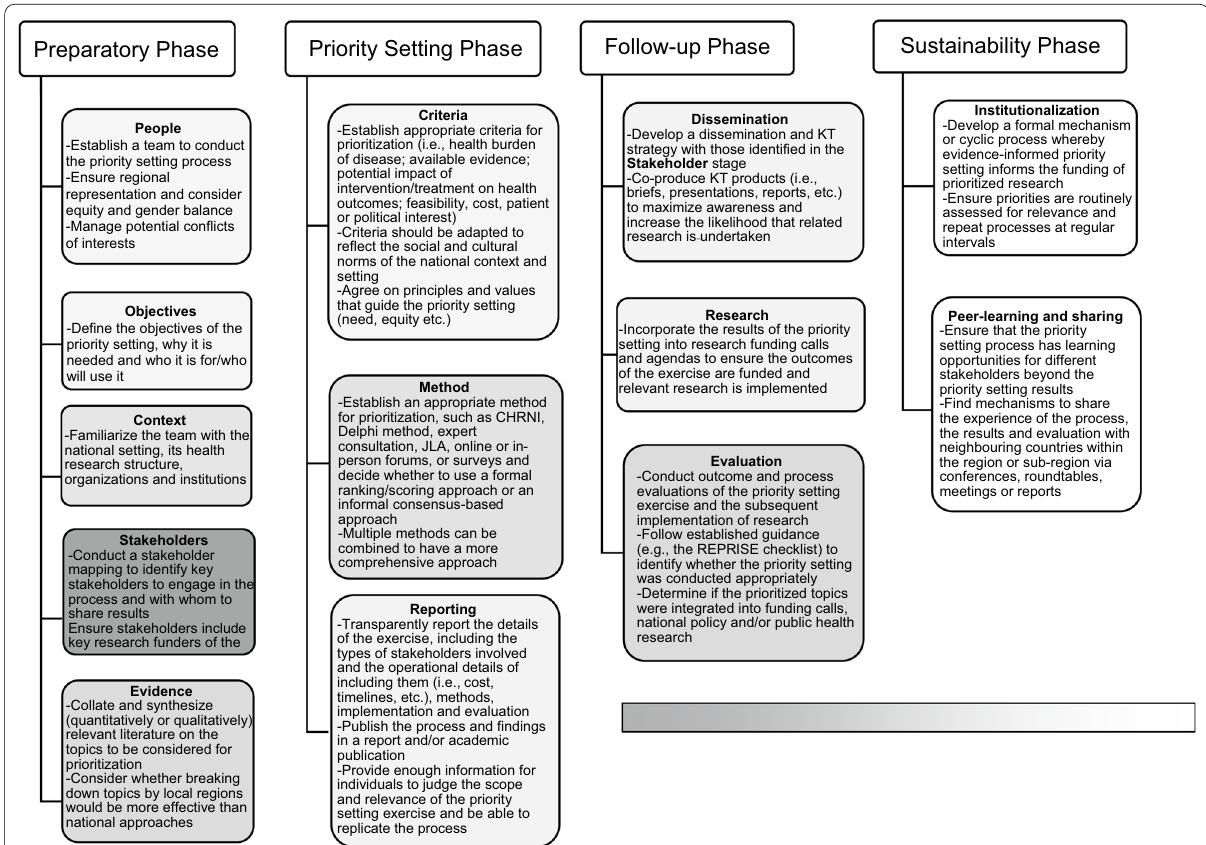
Fig. 2 Priority setting framework. The gradient of grey reflects the frequency with which domains have been considered in existing frameworks, with dark grey representing frequent consideration to white highlighting novel elements identified in the current overview. CHNRI: Child Health Nutrition Research Initiative; JLA: James Lind Alliance; KT: knowledge